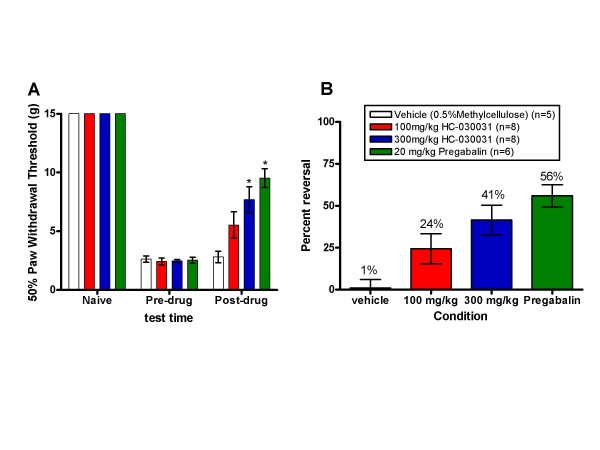
The effect of HC-030031 on spinal nerve ligation induced mechanical hypersensitivity. A. Fifty percent paw withdrawal thresholds for the L5/L6 spinal nerve ligated rats assessed using the Dixon up/down method prior to surgery, prior to dosing with vehicle (white bars), 20 mg/kg pregabalin (green bars), 100 mg/kg HC-030031 (red bars) or 300 mg/kg HC-030031 (blue bars), and at one hour post p.o. dosing. Pregabalin and 300 mg/kg HC-030031 produced a significant attenuation in mechanical hypersensitivity at one hour post dose (*p < 0.05). B. Percent reversal seen at one hour post p.o. dosing with vehicle (white bars), 20 mg/kg pregabalin (green bars), 100 mg/kg HC-030031 (red bars) or 300 mg/kg HC-030031 (blue bars).